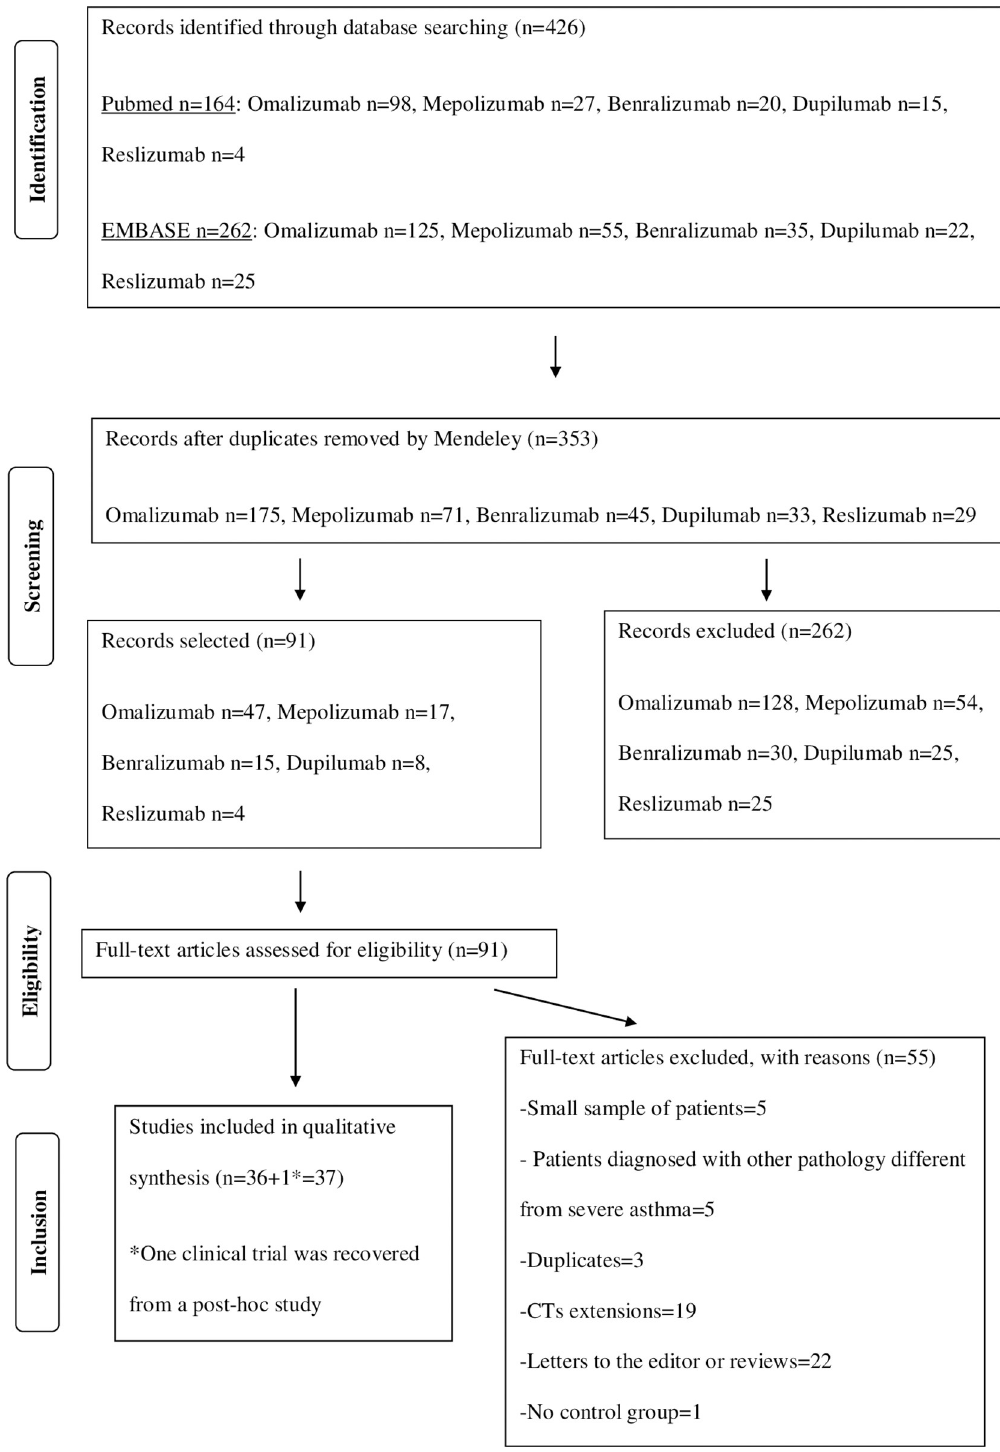
Fig 1. Study selection